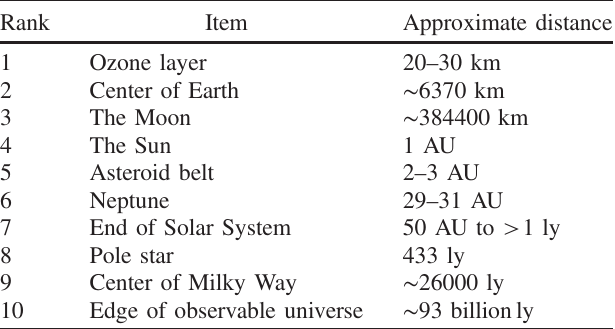
TABLE III. Correct solution to the ranking task in Q7b, along with approximate distances to the items in question (the question did not ask students to give the distances to the objects; these are included here for reference only, and to illustrate the many orders of magnitude in distance spanned by the items). Note: 1 AU (astronomical unit) equals approximately 1 . 5 × 10 8 km; 1 ly (light year) equals approximately 63 000 AU. The distance to the end of the Solar System depends on the definition used, but is not more than a few ly.